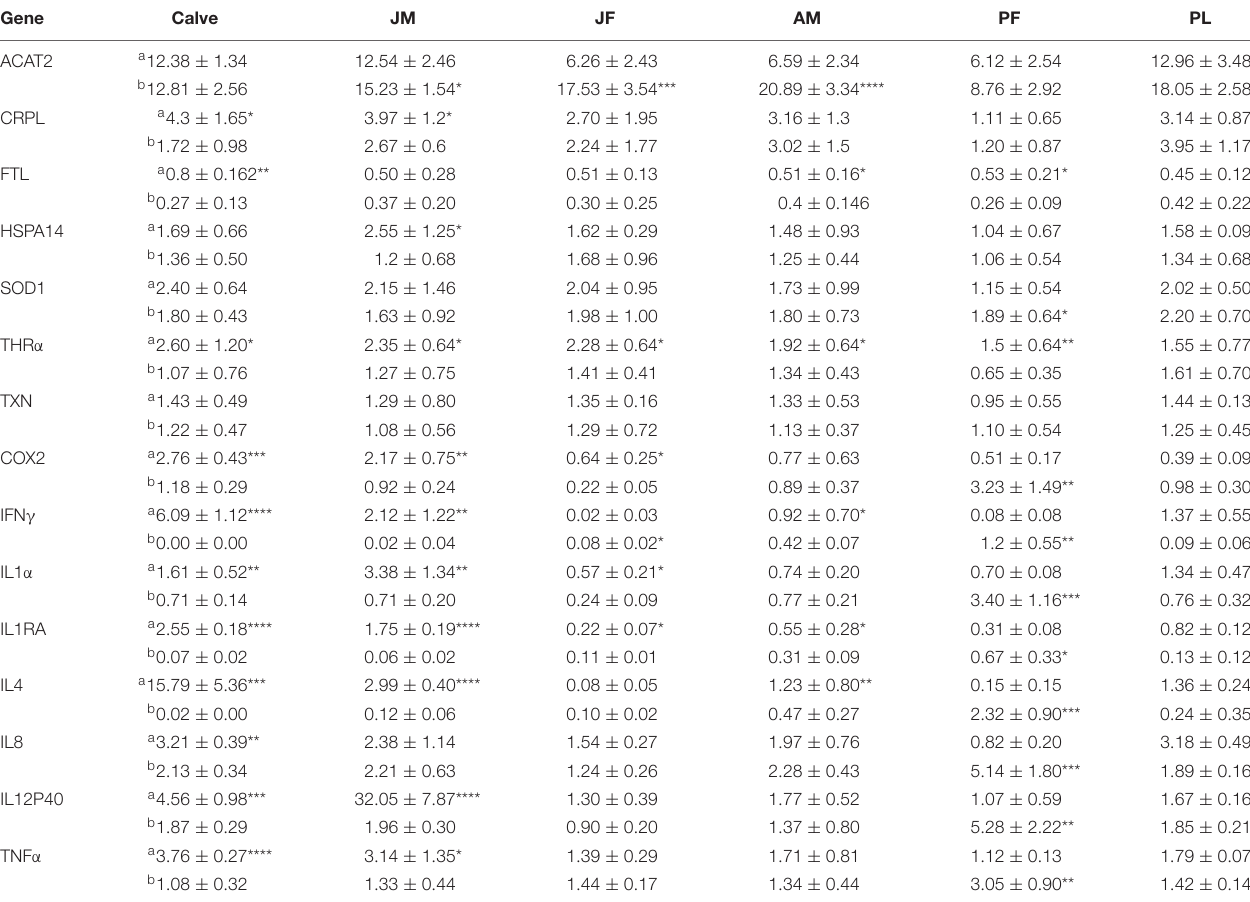
TABLE 3 | Comparisons of qPCR result in matched groups from both